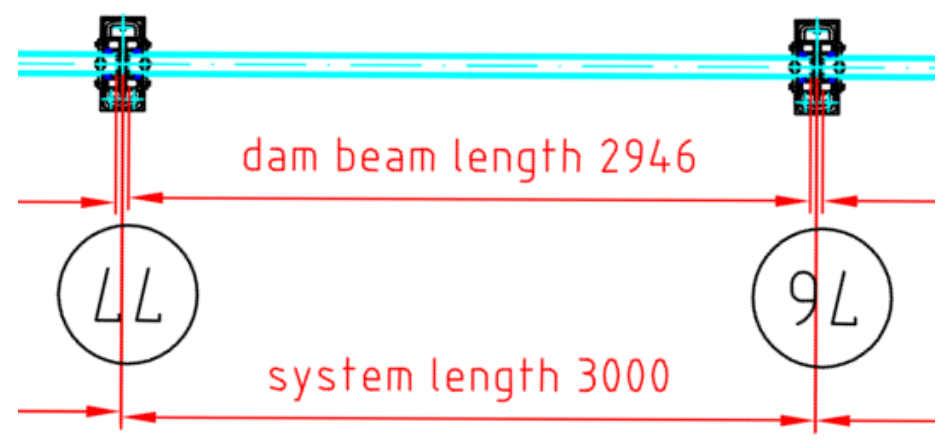
Figure 12. Anchor plate